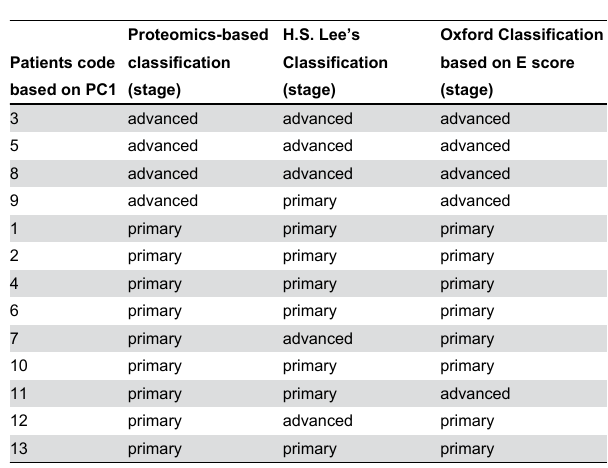
Table 2. A new classification based on proteomics data and comparison with other classification based on